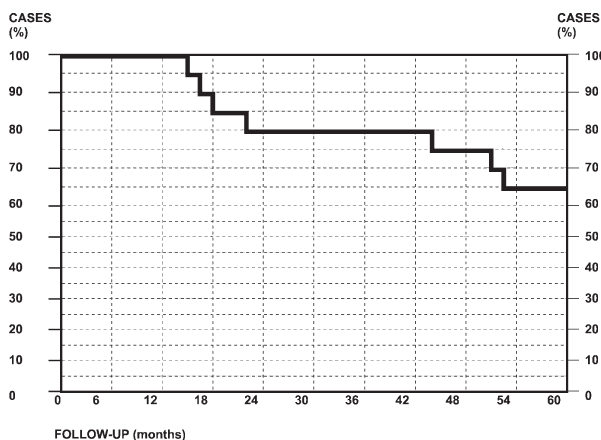
Figure 2 - Kaplan-Meier estimates for disease-related